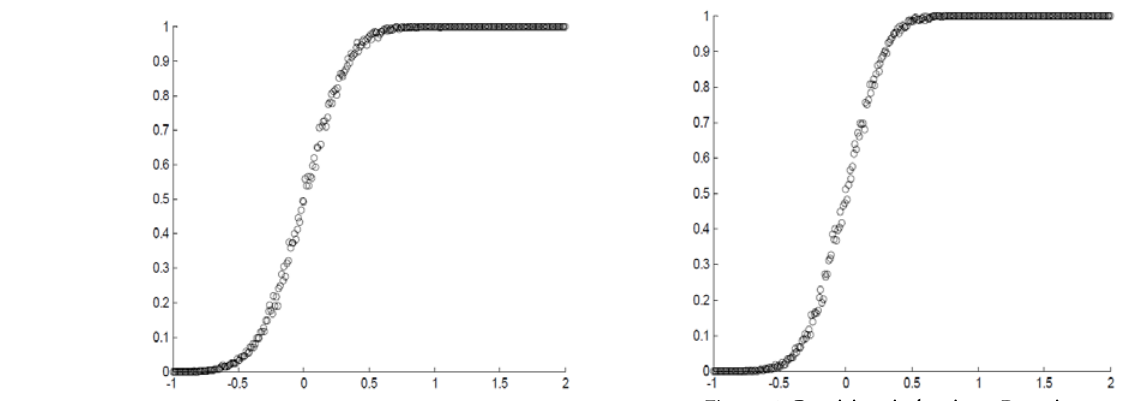
Figure 4 - Prevision index in a Bayesian test case